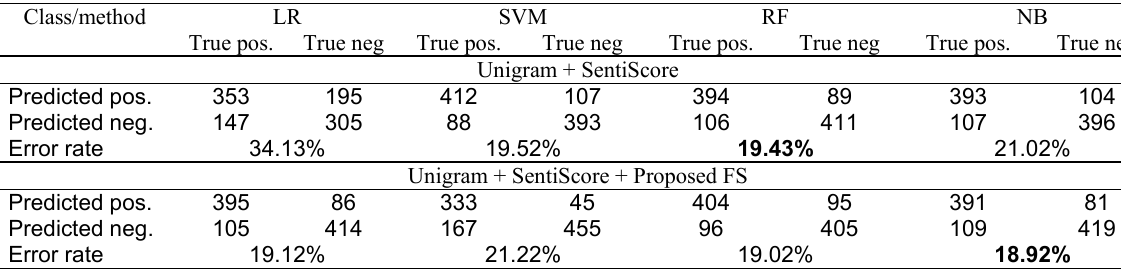
Table 10. Confusion Matrix of Amazon Product Review